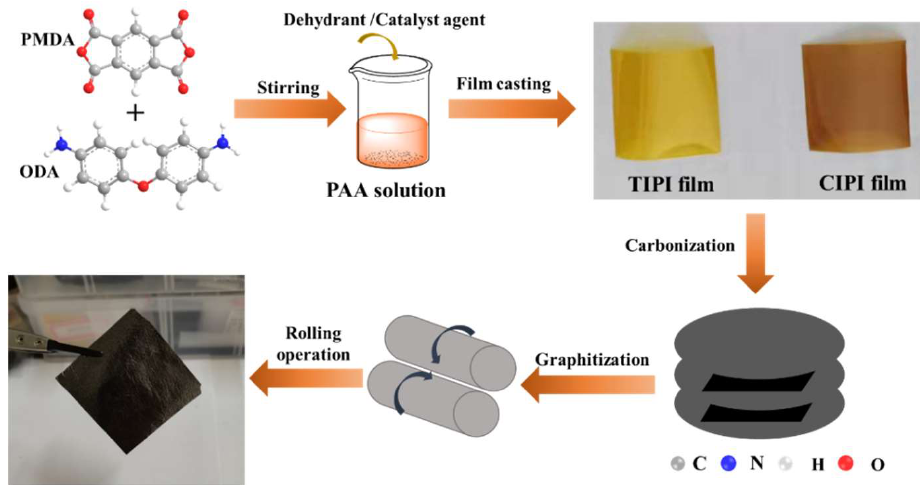
Figure 1. Preparation process of graphite films.